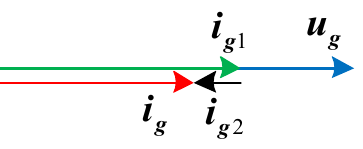
Figure 8. Grid phase